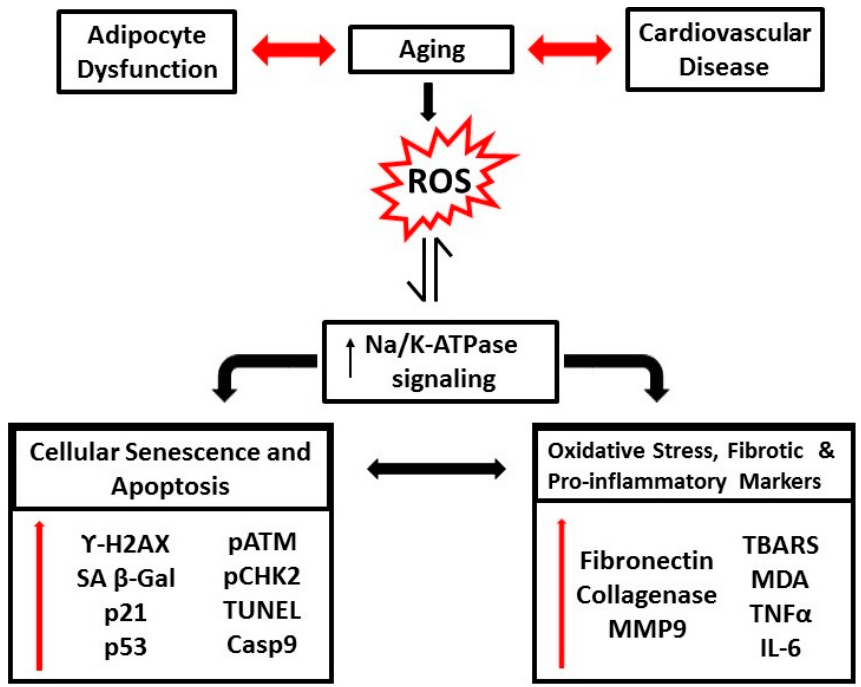
Figure 1. Schematic representation of the pathophysiological alterations in the biological aging process, in association with obesity and cardiovascular disease.